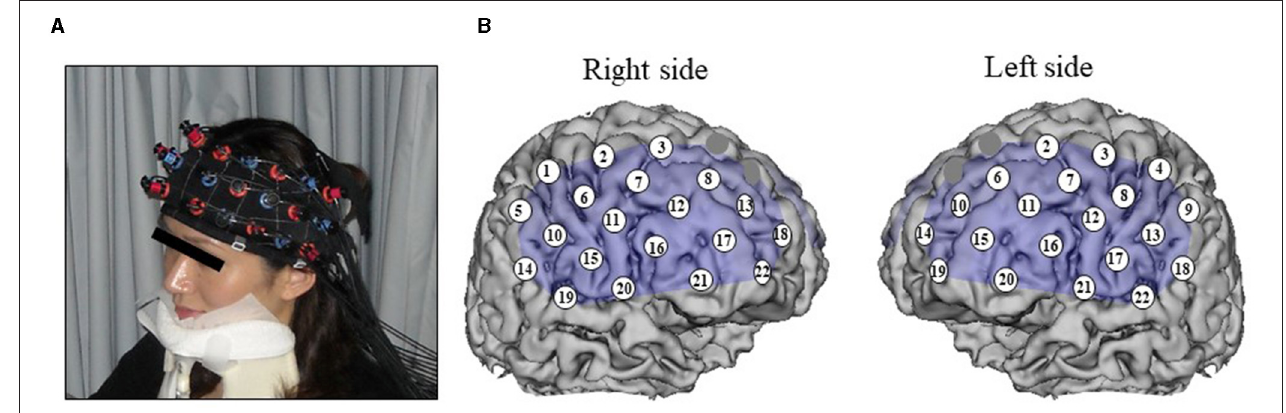
FIGURE 2 | Task design. One session comprised two contrasting conditions (word production tasks, control conditions), and all subjects alternated between these conditions. Each word was visually displayed on the screen for 0.3s as an activation task and then a fixed circle was displayed for 12s. In the activation task, subjects were instructed to say a noun immediately starting with the last kana character of the displayed word. The word production task was repeated 20–25 times per session.